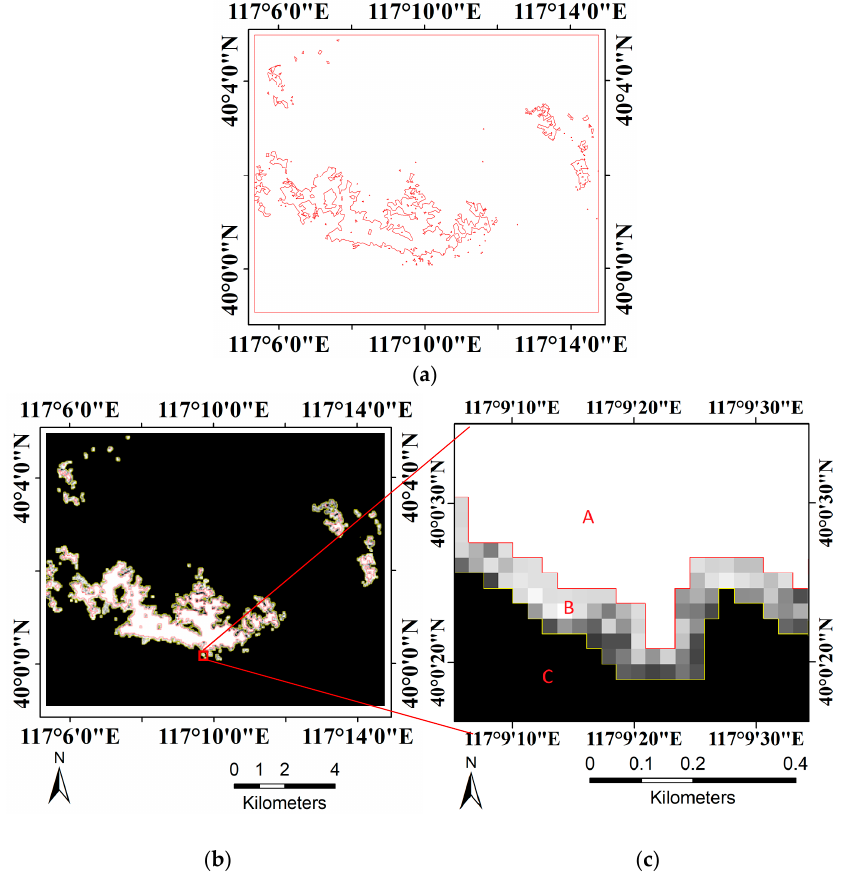
Figure 5. Process illustration using 2002 as an example. ( a ) Edges of quarry; ( b ) Three defined zones; ( c ) Three types of zones in detail: zone (A) is the internal quarry region, which is fully accounted for in the area calculation; zone (B) is the margin of the quarry zone, which is partly accounted for in the area calculation taking the confidence index as a weight coefficient; zone (C) is the region classified as